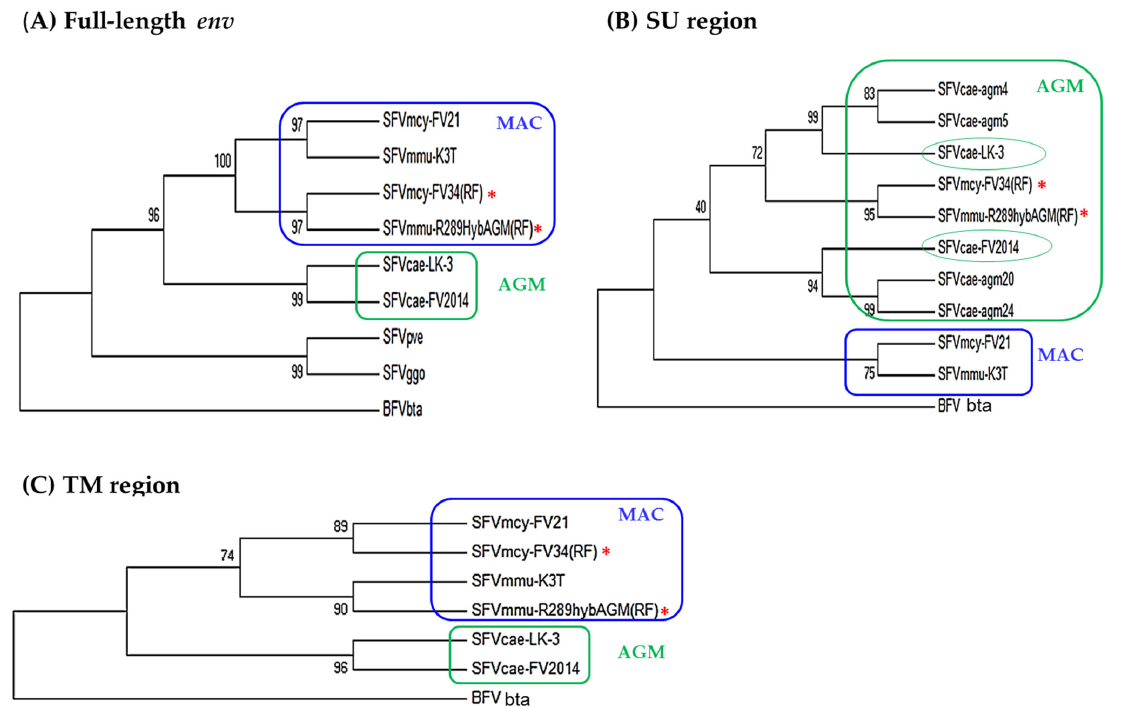
Figure 4. Phylogenetic analysis of SFV env . Results are shown for the nucleotide sequence in: ( A ) full-length env , using 2900 positions in the final dataset; ( B ) SU region using 1305 positions in the final dataset; and ( C ) TM region using 1242 positions in the final data set. The accession numbers of the virus sequences used for the analysis are shown in Table 2. BFVbta was used as the outgroup for all the trees. The percentage of replicate trees in which the associated taxa clustered together in the bootstrap test (1000 replicates) are shown next to the branches. Color indicates the clustering of AGM (green) and MAC (blue) isolates based on analysis of indicated regions in env . Recombinant virus is indicated with an asterisk.